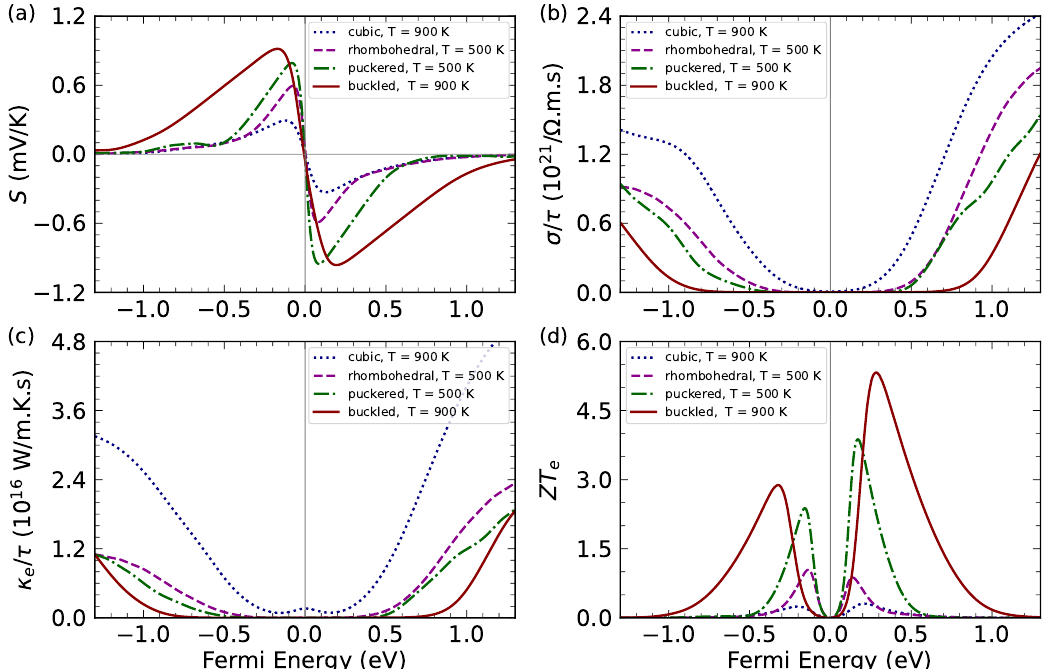
Figure 4. Thermoelectric properties of bulk and monolayer GeTe calculated from band structure information: ( a ) Seebeck coefficient, ( b ) electrical conductivity, ( c ) electronic thermal conductivity, and ( d ) ideal figure of merit. Note that the electrical conductivity and electronic thermal conductivity are scaled by relaxation time constant τ . Considering a possible phase transition at T = 700 K, we set two different values of temperature: T = 900 K for bulk cubic and monolayer buckled GeTe; and T = 500 K for bulk rhombohedral and monolayer puckered